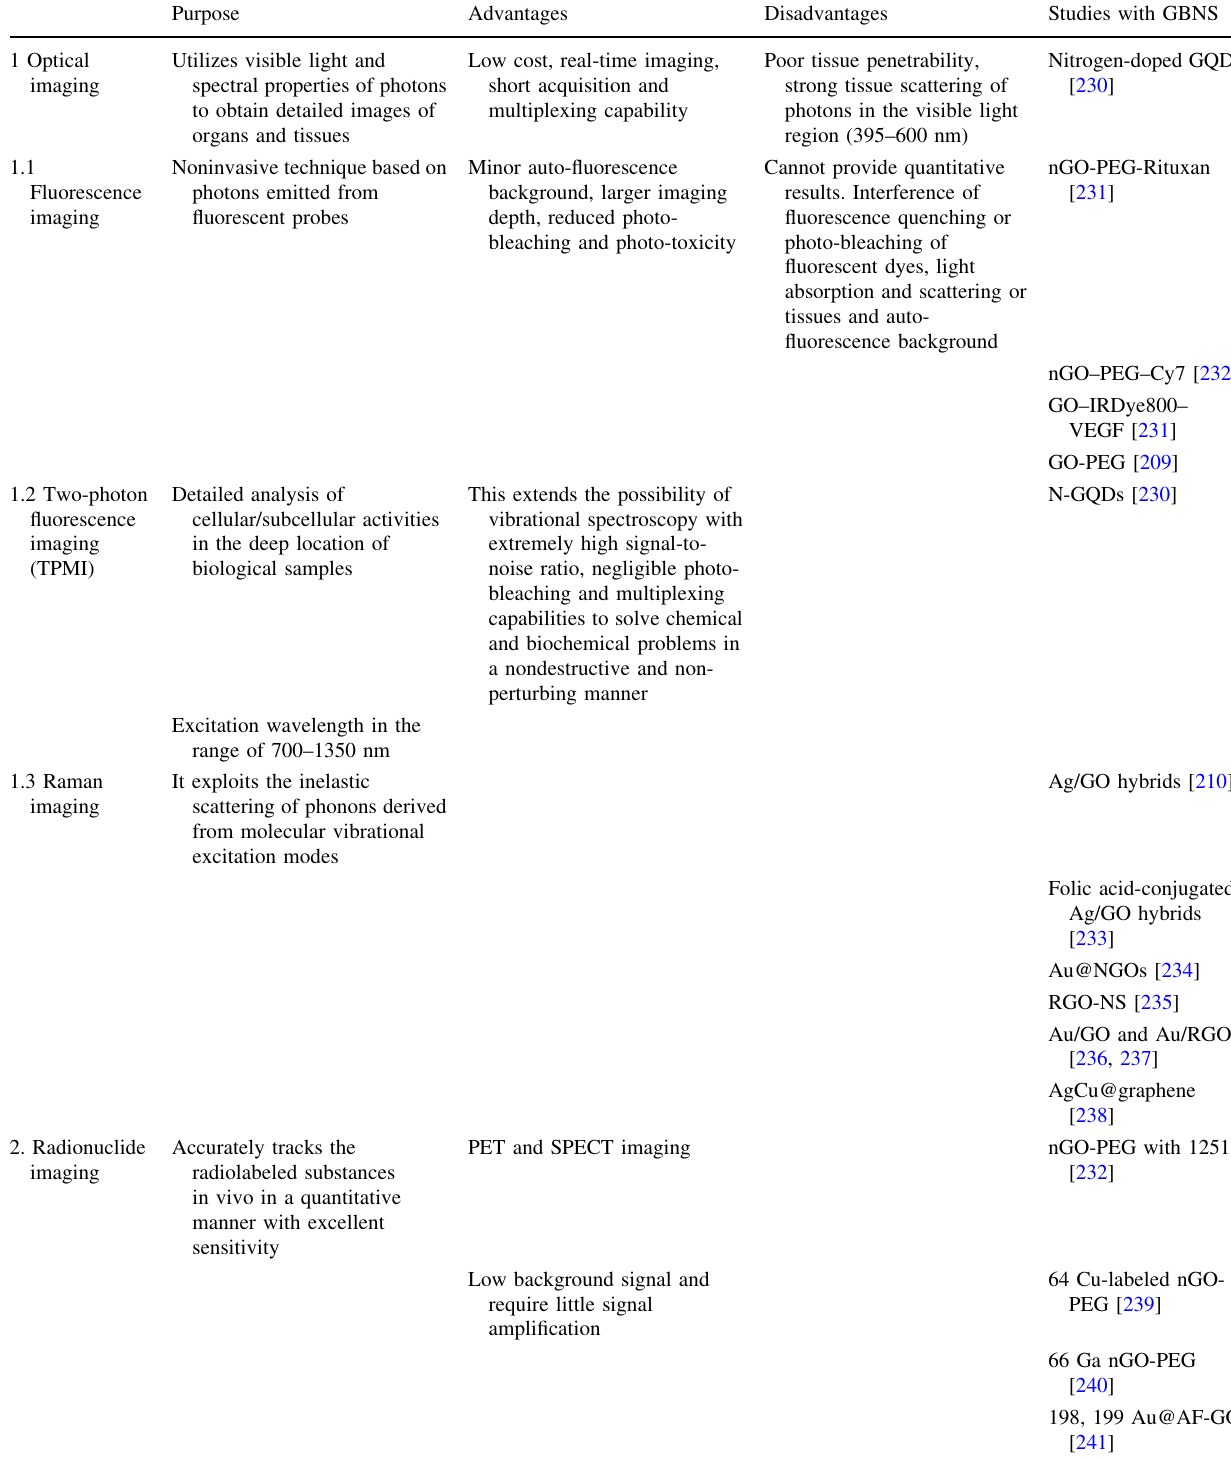
Table 4 GBNs in bioimaging (data adapted from Ref. [33]). Copyright (cid:2) Elsevier